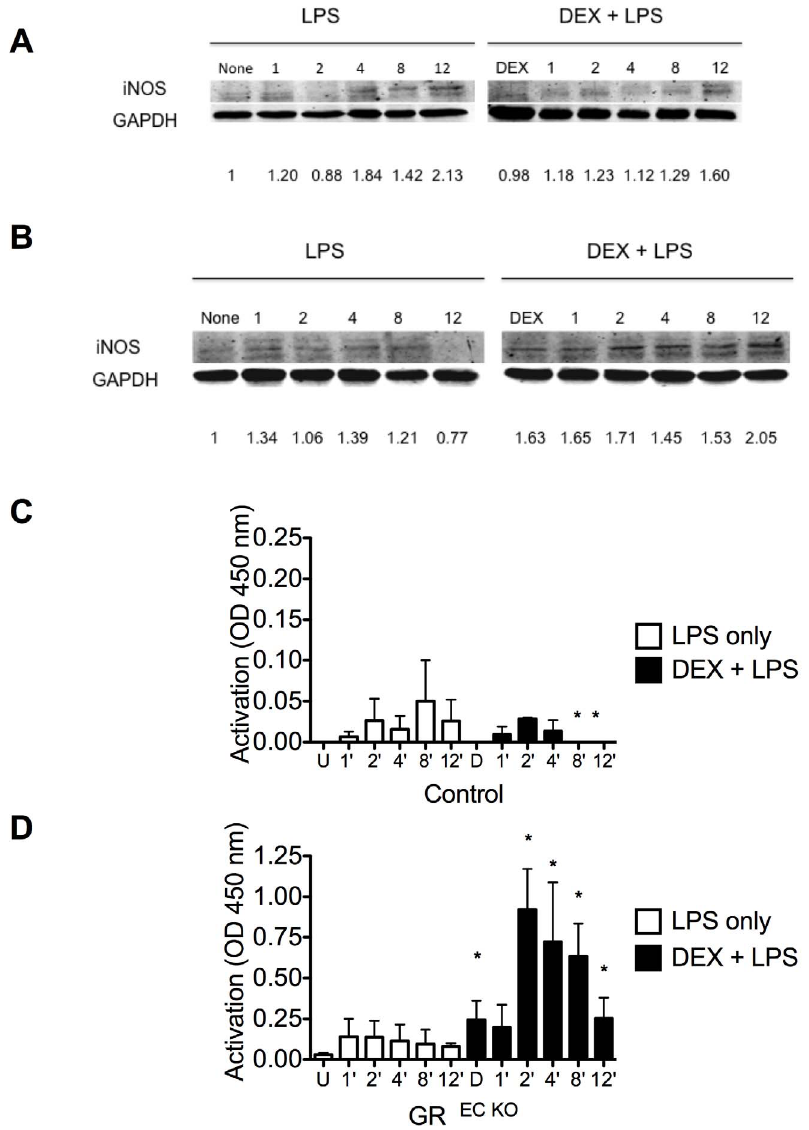
Figure 4. Increased iNOS expression and NF- k B activation in GR EC KO mice. Western blot of aortic homogenates from controls and GR EC KO mice treated with LPS alone or DEX + LPS and harvested at the indicated timepoints. Densitometry values are indicated below each lane. Activation of NF- k B was assayed in the same homogenates. (A) Control mice show decreased expression of iNOS when given DEX + LPS as compared to LPS alone and while (B) GR EC KO mice show increased iNOS levels following DEX + LPS as compared to LPS alone. (C) Activation of NF- k B is suppressed following DEX pre-treatement in control animals while in (D) GR EC KO mice increased activation of NF- k B is shown at every time point. *p , 0.05 compared to similarly treated control. U=untreated,